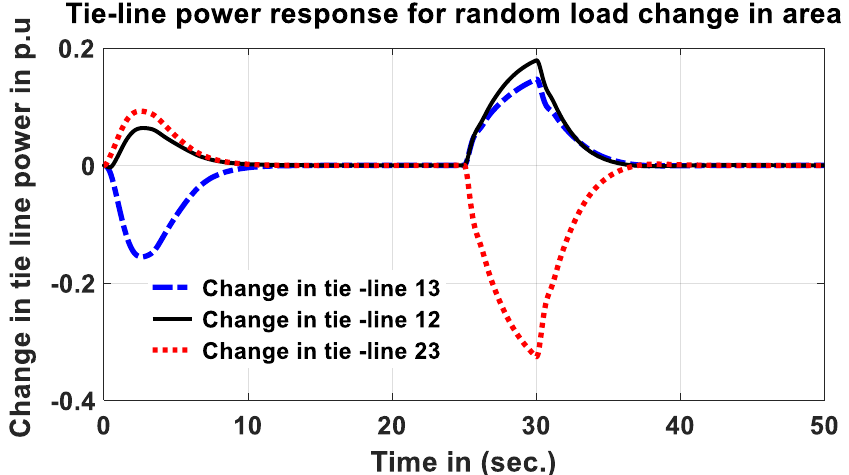
Figure 28. Change in tie-line power responses of area 1, area 2, and area 3 for random load change in area 3 only.